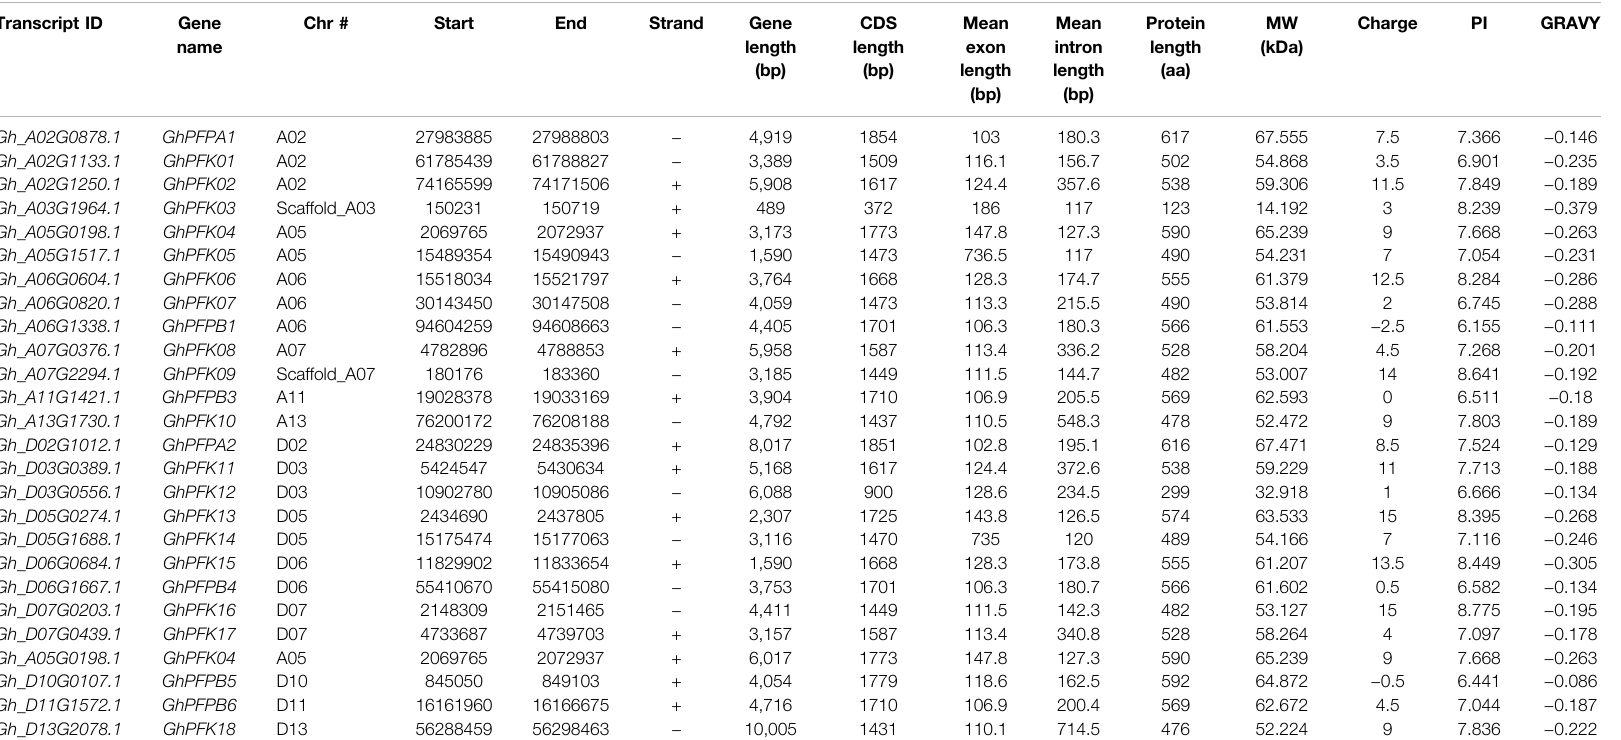
TABLE 1 | Transcript and physiochemical features of PFK genes in G. hirsutum